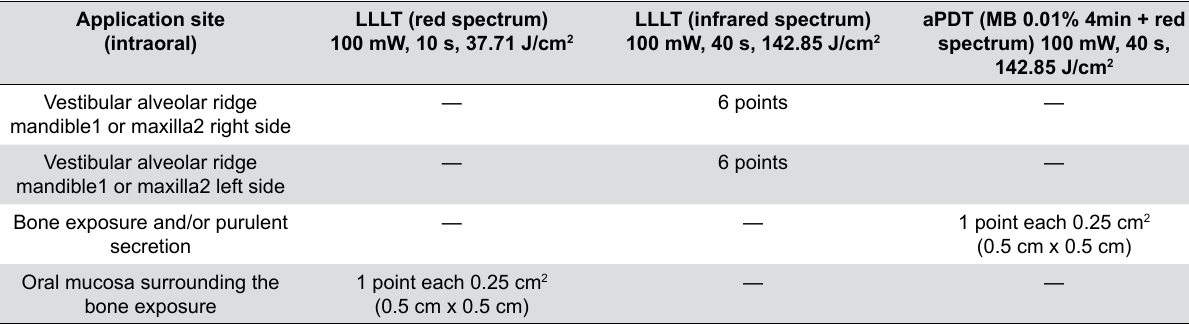
Application site